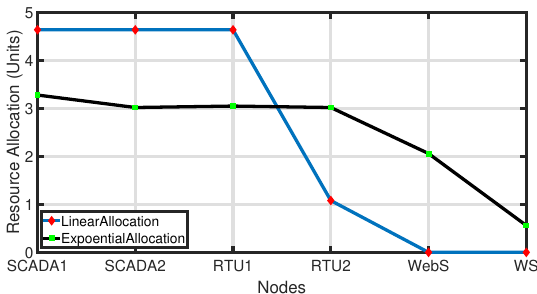
Figure 5. Linear and exponential resource allocation